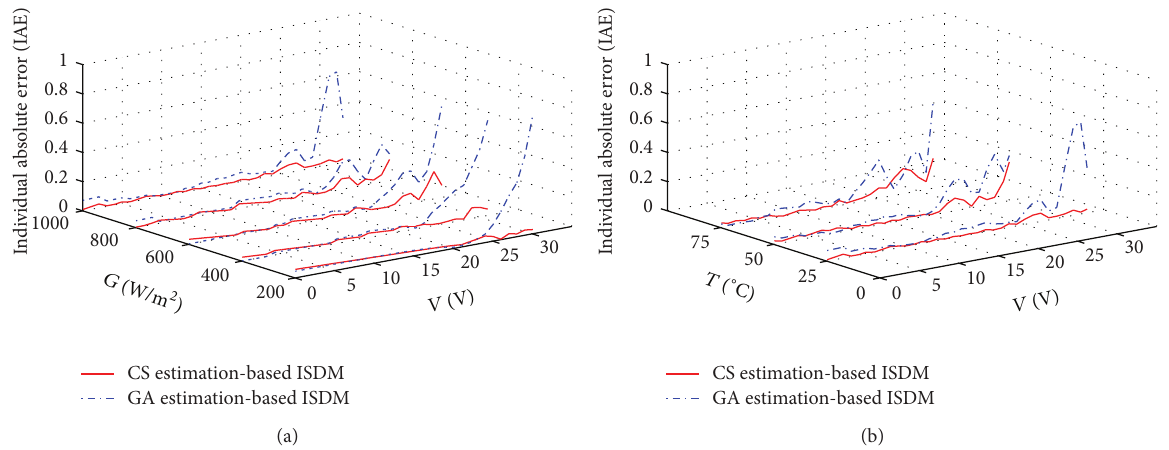
Figure 5: A comparison of the individual absolute errors between CS- and GA- based ISDM: (a) under different irradiance levels; (b) under different temperature